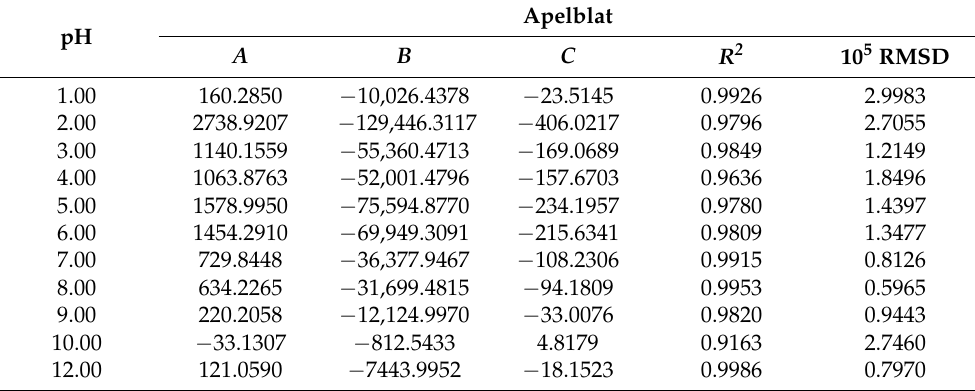
Table 3. Parameters of Apelblat equation estimation for the solubility of phenylglycine in water.